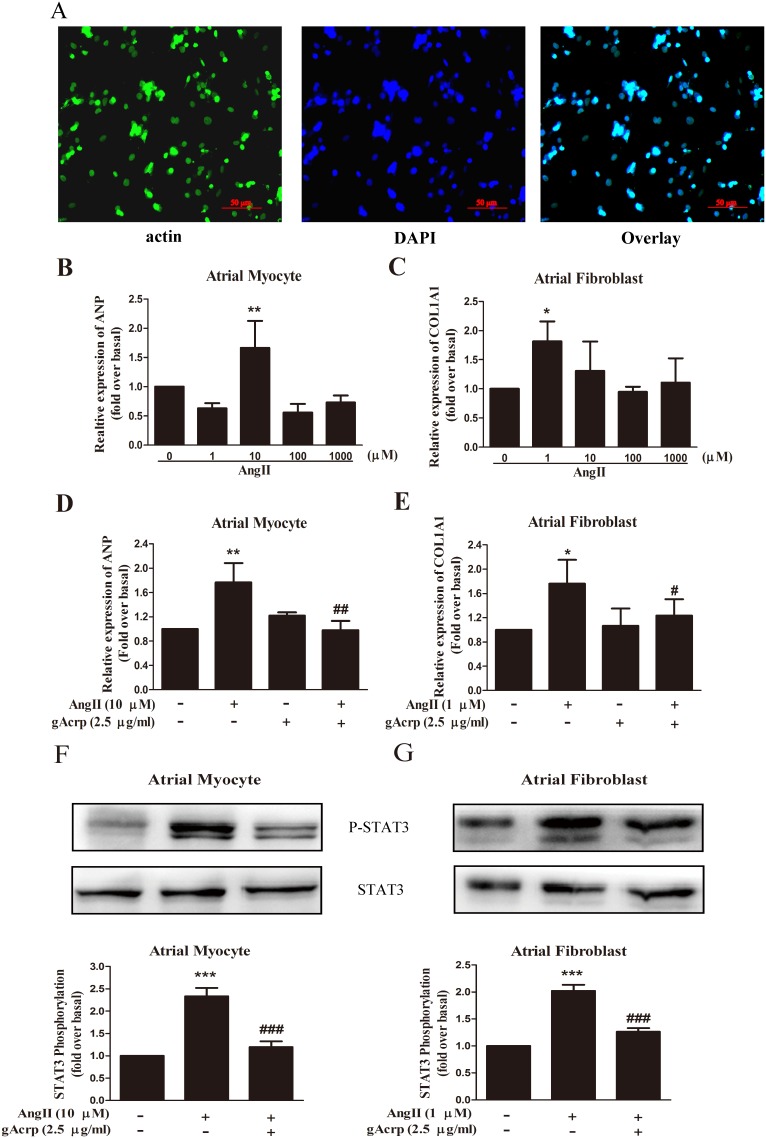
The effect of gAcrp on hypertrophy and fibrosis in atrial myocytes and fibroblasts treated with AngII.(A) Fluorescence microscopy images depict the α-cardiac actin (green) expression in atrial myocytes. The cell nuclei were stained with DAPI (blue). Scale bar, 50 µm. (B) and (C) Quantitative real time PCR analysis of ANP and COL1A1 expression in cultured atrial myocytes and fibroblasts treated with AngII (24 h). Data were expressed as mean ± SD, n = 3. *P<0.05, **P<0.01 vs. blank control. (D) and (E) Quantitative real time PCR analysis of AngII-stimulated expression of ANP and COLIA1 for 24 h after pretreatment with gAcrp (2.5 µg/ml) for 60 min in cultured atrial myocytes and fibroblasts. Data were expressed as mean ± SD, n = 3. *P<0.05, **P<0.01 vs. blank control; #
P<0.05, ##
P<0.01 vs. AngII treatment. (F) and (G) Phosphorylation expression of STAT3 induced by AngII and attenuated by gAcrp (2.5 µg/ml) in cultured atrial myocytes and fibroblasts. Upper panels show immunoblotting representatively; bottom photos show quantification by densitometry. Whole cell lysates were subjected to Western blot analysis using a specific antibody as described in Materials and Methods. Data were expressed as mean ± SD of three independent experiments. ***P<0.001 vs. blank control; ###
P<0.001 vs. AngII infusion.